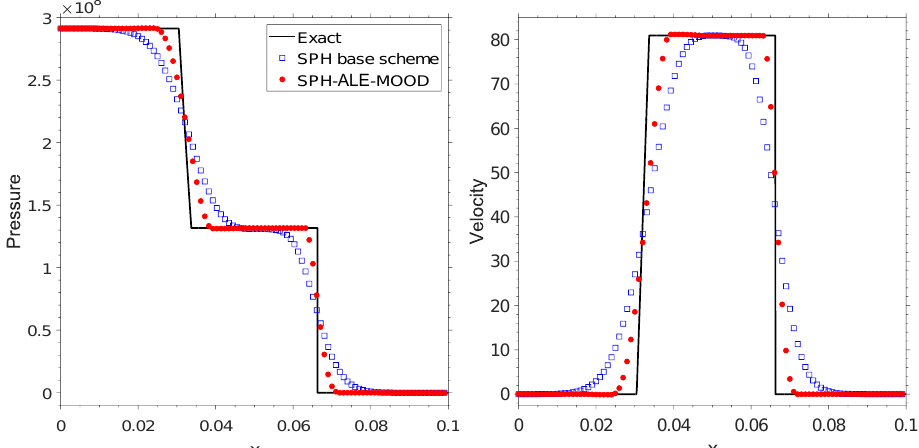
Figure 3. 1D shock tube problem (R1): Pressure and velocity at at time t final = 10 − 5 s using 100 particles in the domain [ 0,0.1 ] m. Results obtained using the SPH base scheme (empty squares) and the SPH-ALE-MOOD method (filled circles).